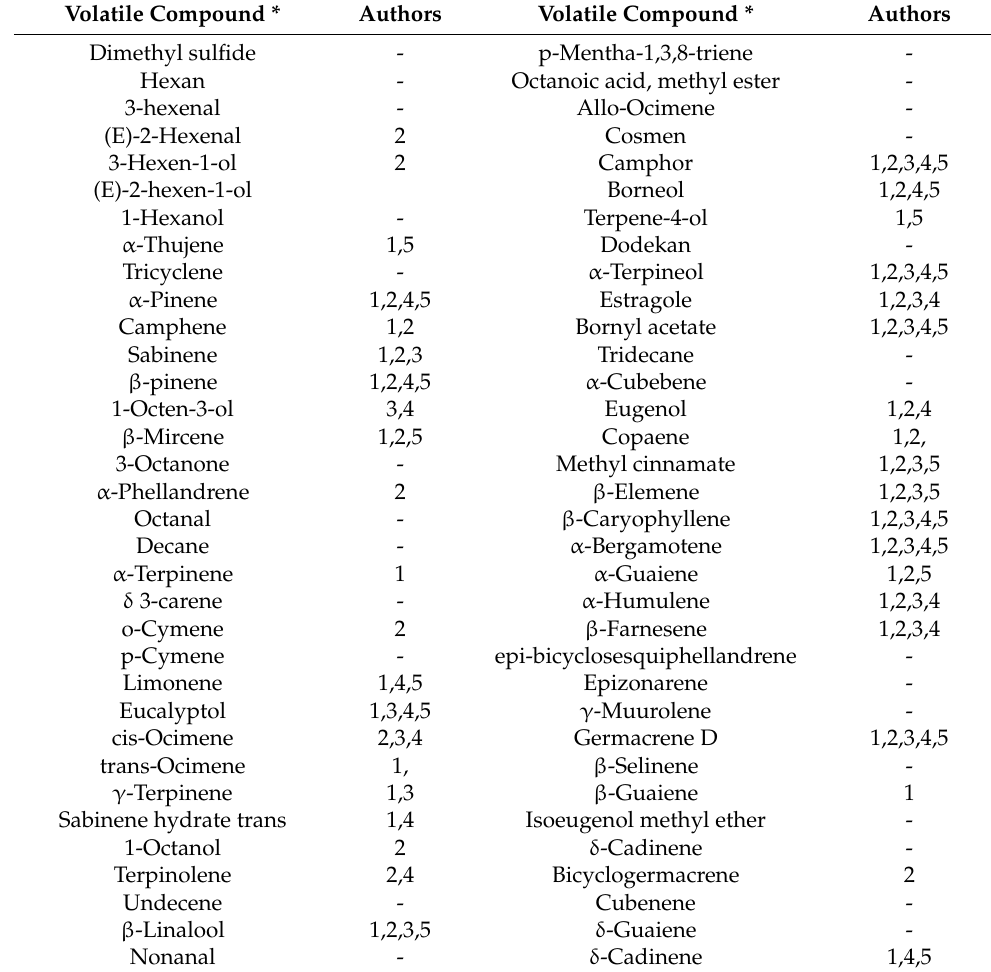
Table 4. List of volatile compounds identified in basil infusions by other authors. Volatile Compound